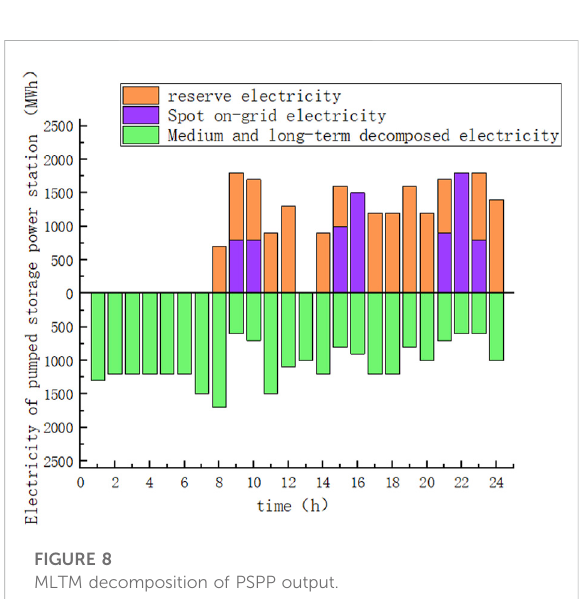
FIGURE 7 Time share power curve for daily contracts.